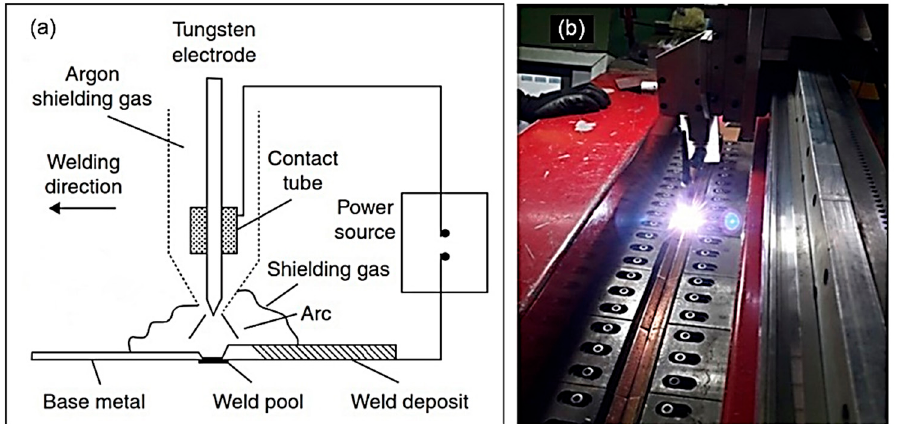
Figure 1. ( a ) Schematics of GTAW process, ( b ) GTAW of S500MC steel in butt configuration.